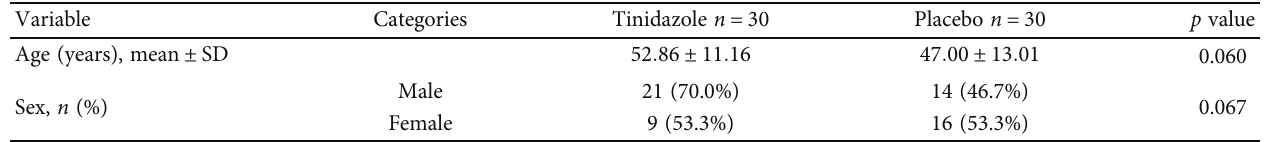
Figure 2: Frequency of cough and dyspnea as graded by clinical staging by the authors, before and after treatment with tinidazole and placebo in subjects su ff ering from persistent cough. Table 1: Characteristics of demographic data of studied population ( n = 60